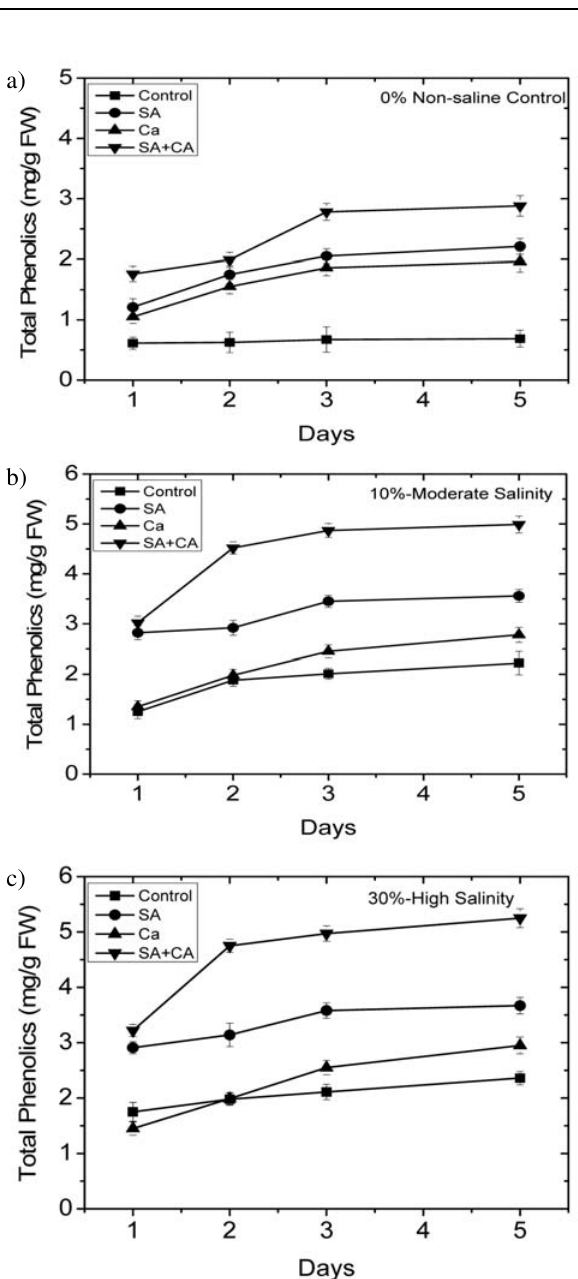
Figure 3. Total Phenolic contents in seedlings of wheat under three different stres conditions a) Non-saline b) 10%-Moderate salinity and c) 30%-High salinity: with four traetments (- (cid:2) -), control; (- (cid:3) -), 0.5 mM SA; (- (cid:2) -), 50 mM Ca +2 ; (- (cid:3) -), 0.5 mM SA+50 mM Ca +2.